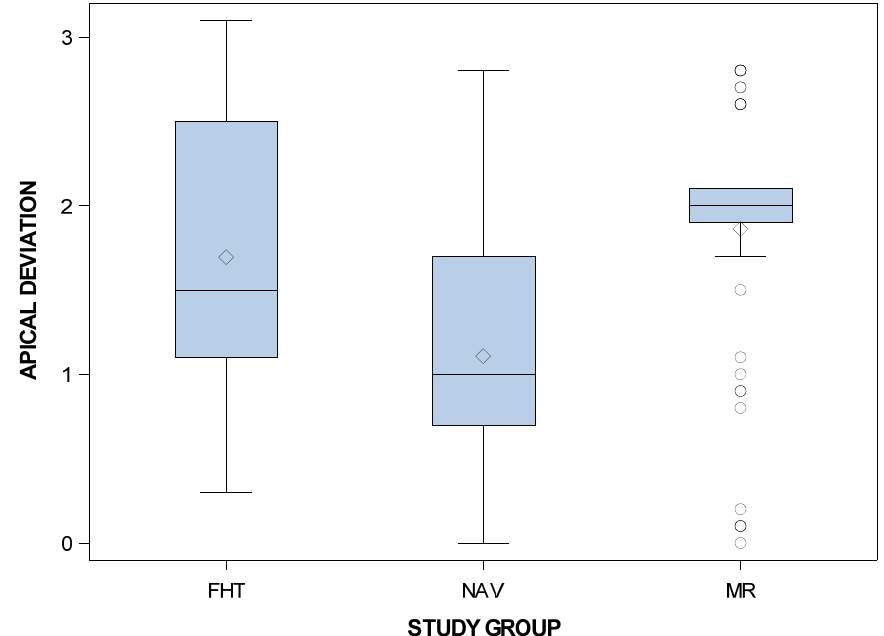
Figure 8. Box plot of the apical deviations in planned and placed orthodontic micro-screws between computer-aided static navigation technique, mixed reality technique and conventional freehand technique study